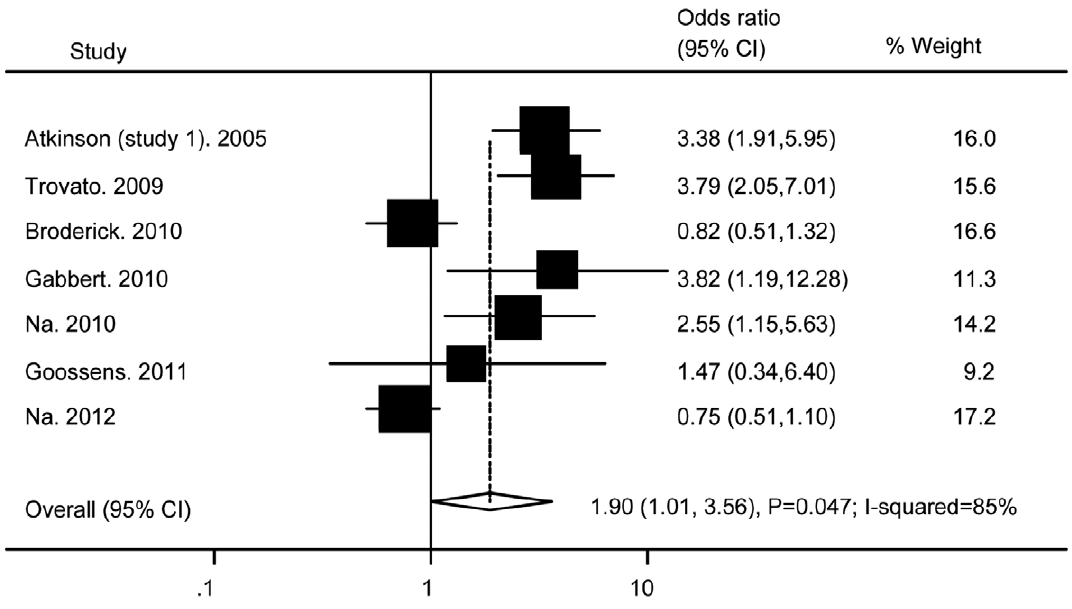
Figure 3. Association of Ad36 with obesity.